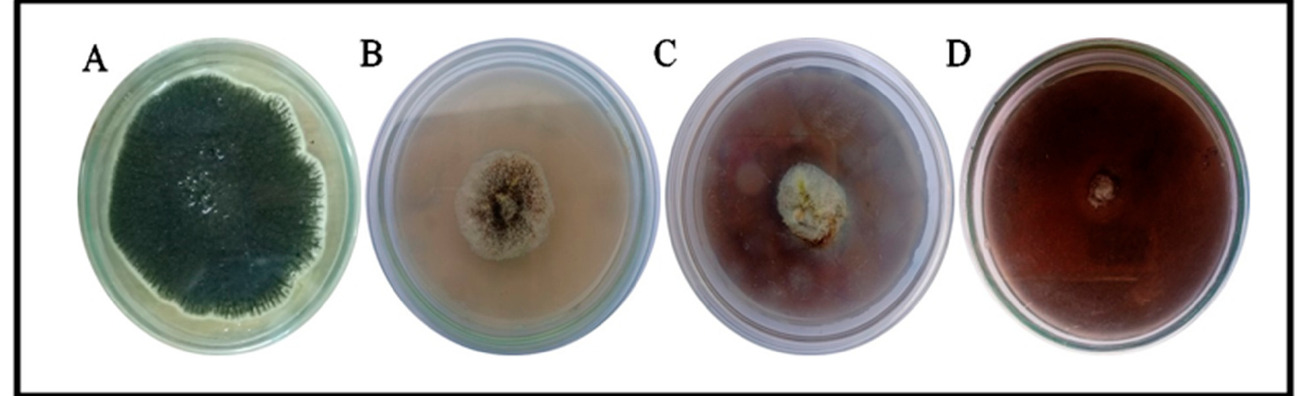
Figure 12. Antifungal potential of MB-ZnO nanocomposites. Fungal growth was observed in control ( A ), and at different concentrations of MB-ZnO nanocomposites including 6 mg/mL concentration ( B ), 12 mg/mL concentration ( C ) and 19 mg/mL concentration ( D ).